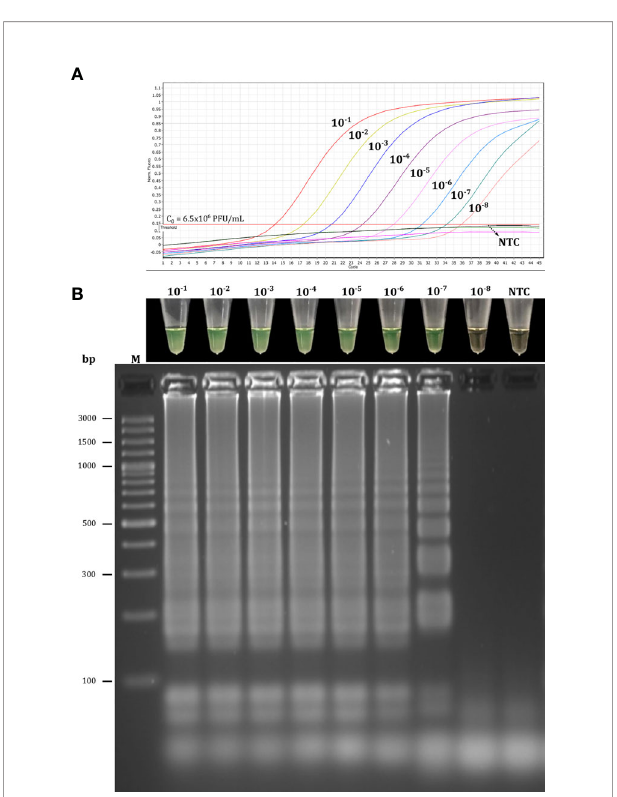
FIGURE 10 | Analytical sensitivity of the multiplex RT-LAMP assay using SARS-CoV-2 RNA from cell culture. Limit of detection (LoD) was assessed using log-dilutions (10 -1 to 10 -8 ) of RNA extracted from SARS-CoV-2 from cell culture with initial titration (C o ) from 6.5×10 6 PFU/mL that were analyzed in parallel by the RT-qPCR (A) and RT-LAMP (B) assays. The LoD of the multiplex RT-LAMP assay was 0.65 PFU/mL (log-dilution 10 -7 ). It was de fi ned as the lowest concentration of SARS-CoV-2 RNA at which ≥ 95% of replicates (n = 20) showed positive results. RT-LAMP reactions were considered positive for SARS- CoV-2 RNA if they had both a color change from brown to green and a laddered banding pattern on agarose gel after electrophoresis. NTC, negative non-template control; M, molecular marker; bp, base